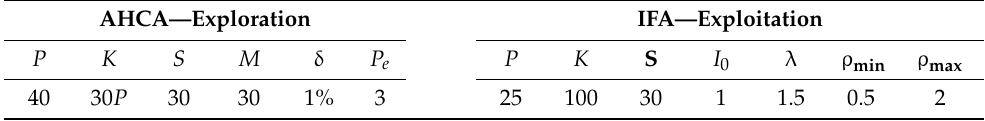
Table 2. Configuring parameters of metaheuristics.